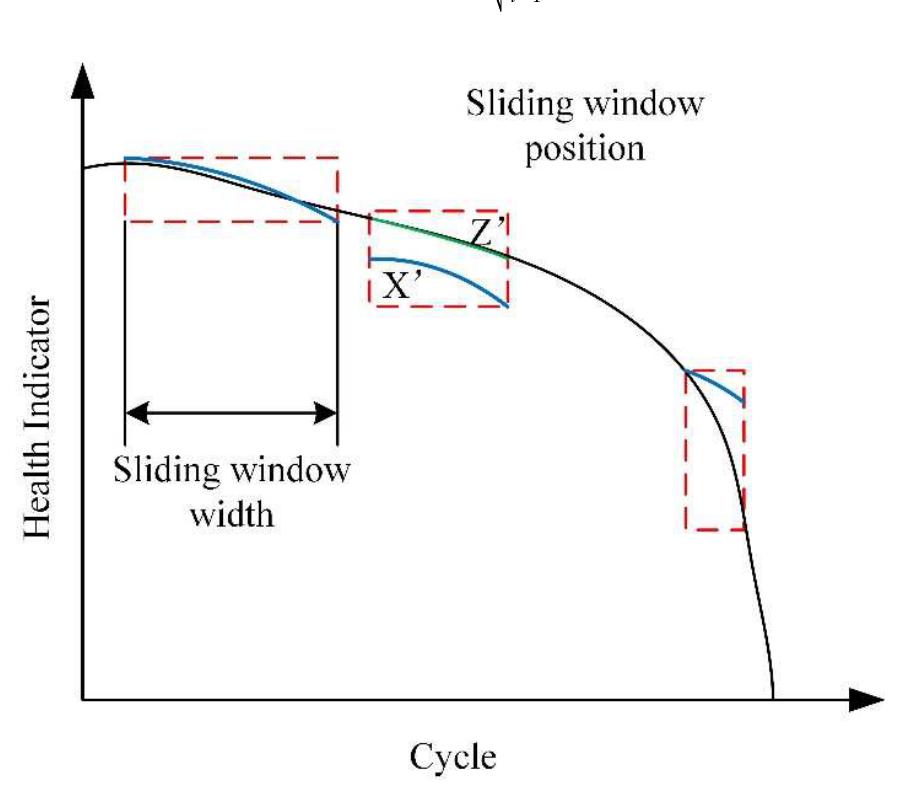
Figure 7. Segment similarity comparison.